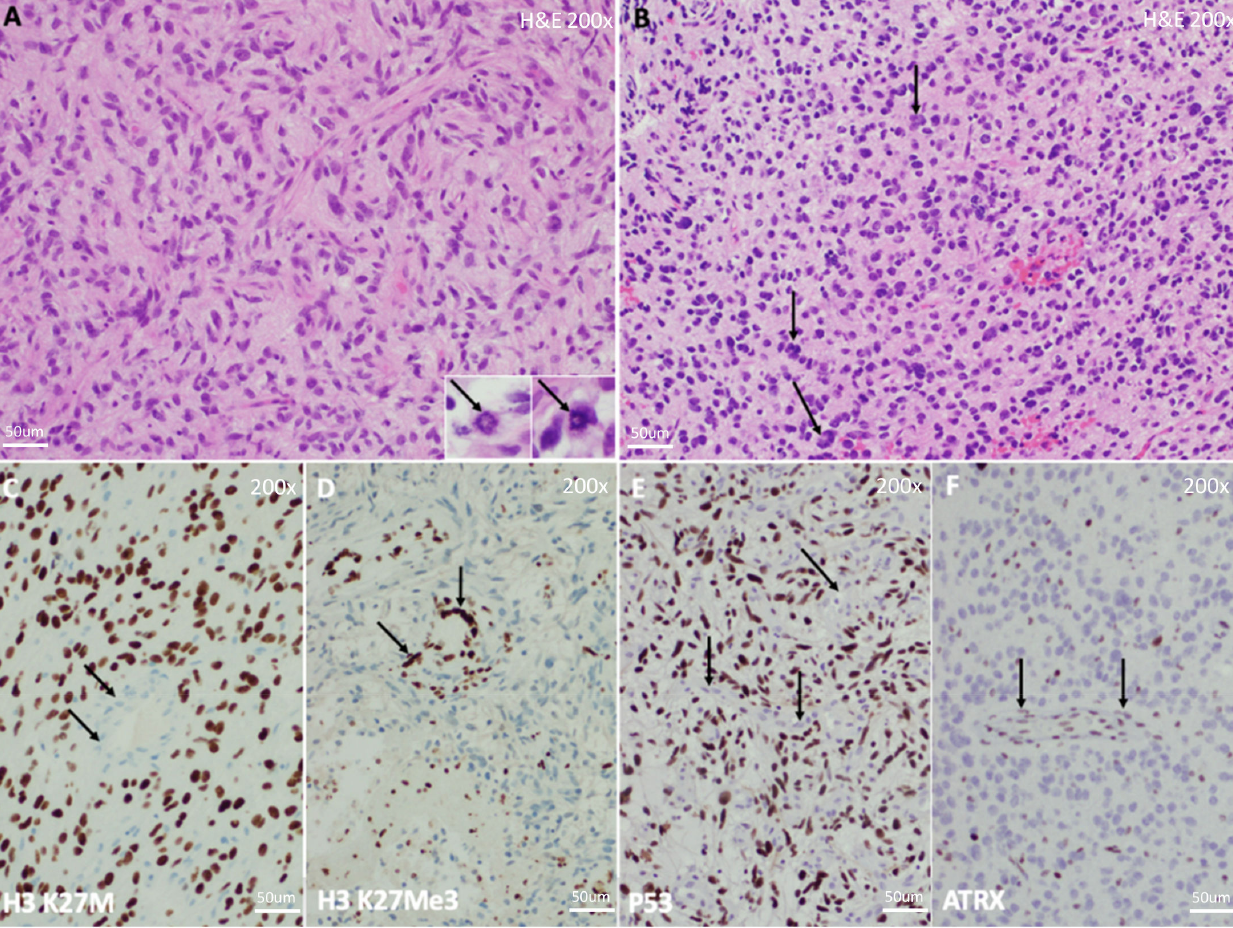
Figure 2. Histology of H3 K27 -Altered DIPG. Histology of Diffuse Midline Glioma, H3 K27 -Altered, WHO Grade 4, the most common tumor comprising DIPG. ( A ) Microscopy demonstrates a high grade, infiltrative glioma with large, atypical, and hyperchromatic nuclei in a fibrillary background. Though high-grade features, including mitotic figures (inset, arrows), are not requisite for the diagnosis, they are generally easy to detect. Microvascular proliferation and necrosis may be variably present and may not be represented on small biopsies. ( B ) Another tumor from a different patient, demonstrating somewhat variable histology, in this case with particularly hyperchromatic, round, and atypical nuclei with frequent multinucleation (arrows). ( C ) Immunohistochemistry demonstrates diffuse nuclear positivity with an antibody detecting the H3 K27M mutation, which is diagnostic for this tumor. Note adjacent negativity within blood vessels and infiltrated non-neoplastic brain parenchyma (arrows), serving as a negative internal control. ( D ) H3K27Me3 immunostaining, which detects trimethylation at the K27 residue, is always lost secondary to the K27M mutation and should be used as a confirmatory stain in making the diagnosis, though DNA sequencing is the diagnostic gold standard. Adjacent non-neoplastic tissue retains trimethylation, and stains positive (arrows). TP53 and/or ATRX mutations are frequent within these neoplasms, which generally manifest as diffuse nuclear positivity for the TP53 protein by immunostaining ( E ), or loss of nuclear positivity for the ATRX protein ( F ). Note negative and positive non-neoplastic tissue, respectively, serving as internal controls